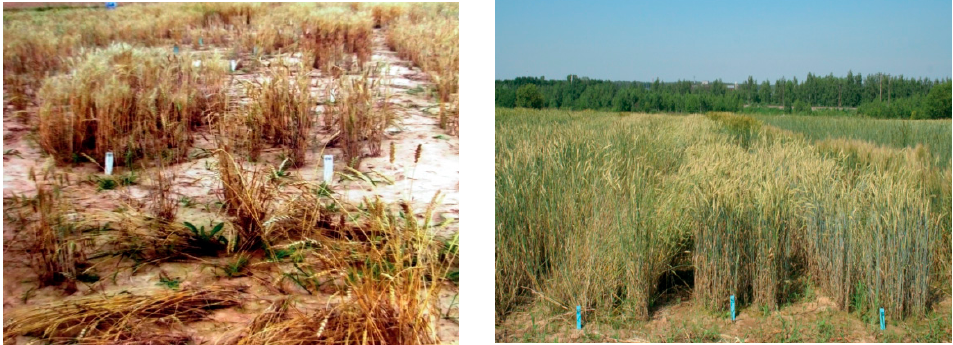
Figure 2. Wheat regeneration ability in spring after abiotic stress (winter hardiness) .